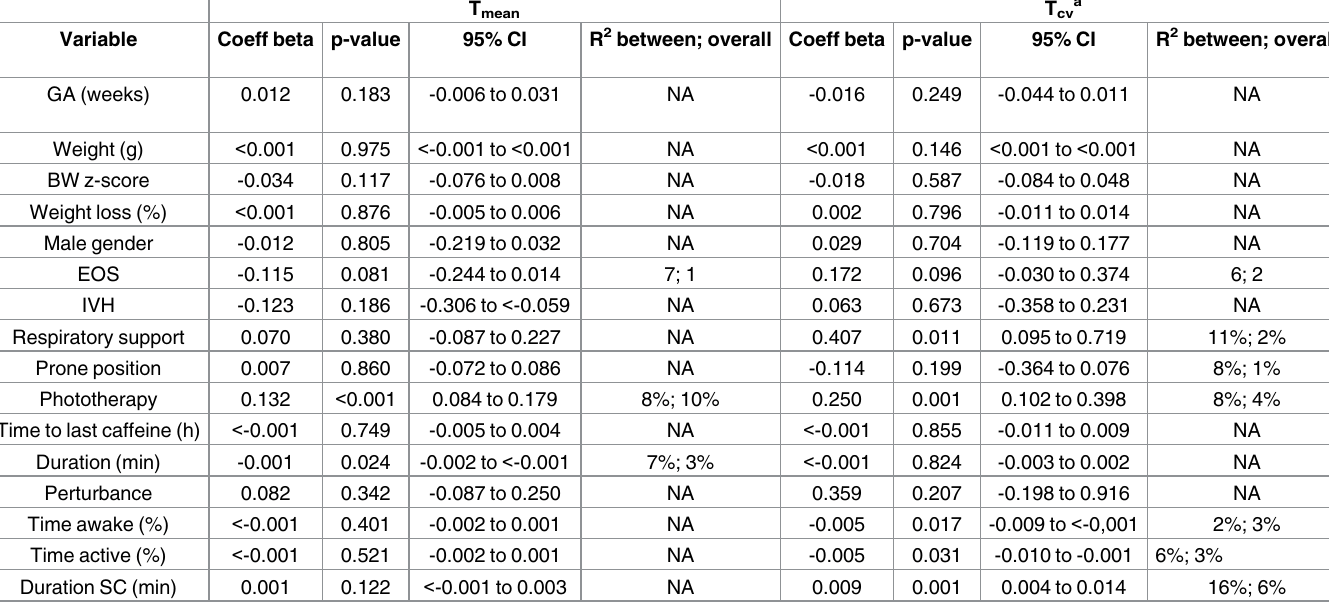
Table 2. Univariable, multilevel linear regression analysesof mean and coefficient of variation of body